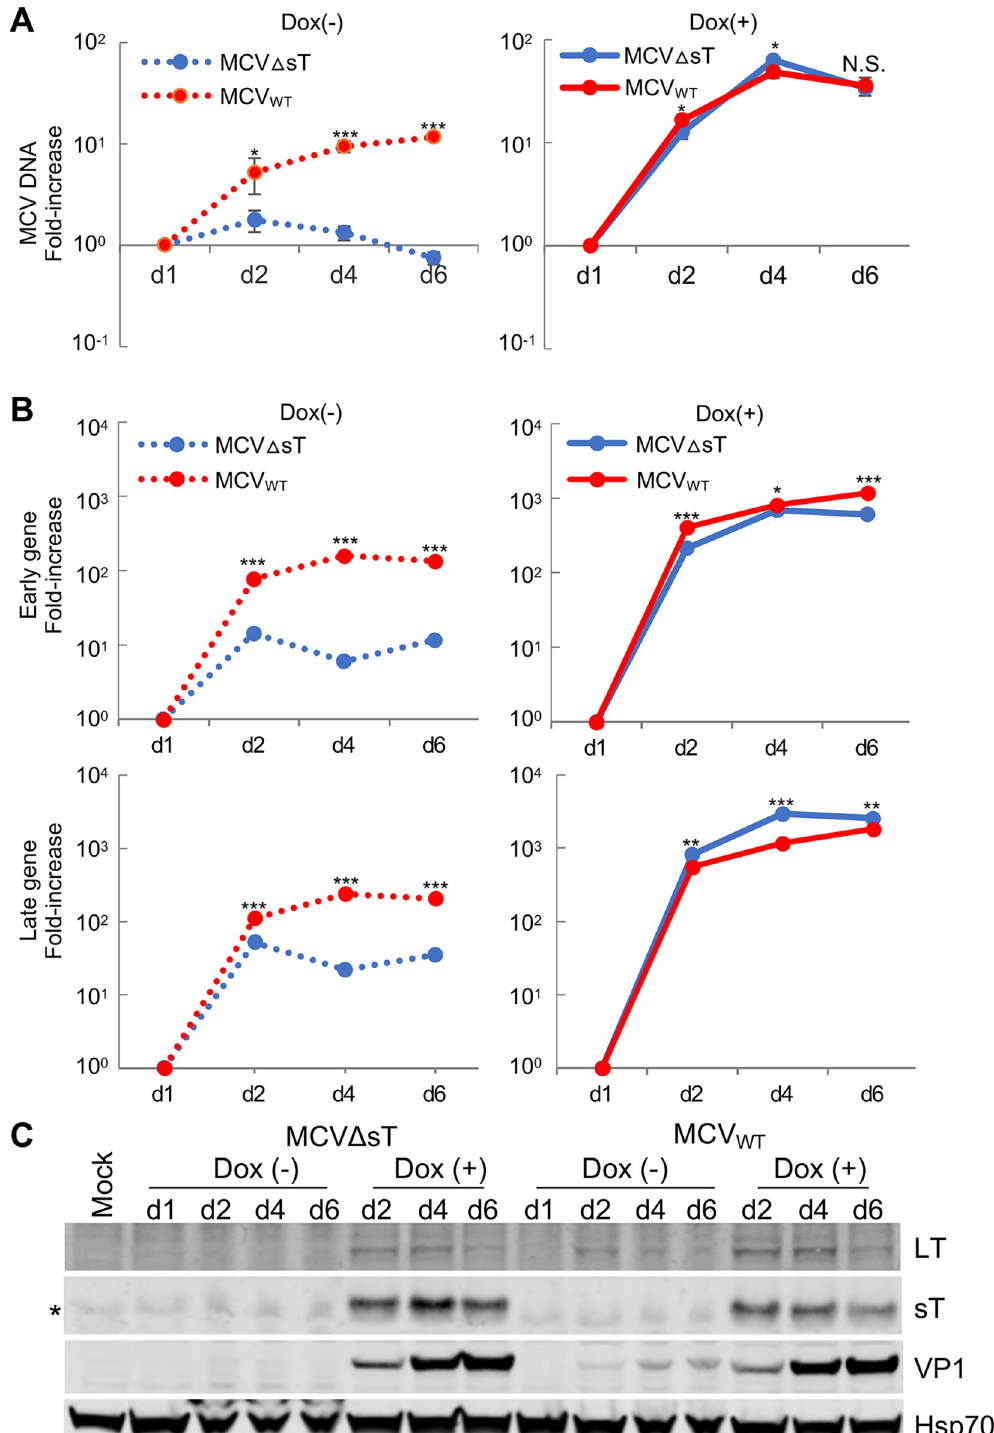
Fig 2. Exogenous sT expression rescues viral DNA replication and mRNA expression in MCV Δ sT. MCV WT and MCV Δ sT viral DNAs were transfected into TRE-sT cells seeded for a 6-day time course experiment. Cells were harvested 24 h p.t. and the remaining cells were treated with or without doxycycline (Dox) at day 1 (0.5 μ g/mL) and paired samples were harvested at day 2, day 4, and day 6 p.t.. Time kinetics in DNA replication, gene expression, and protein expression in both MCV WT (red lines) and MCV Δ sT (blue lines) were analyzed. Unpaired T-test was used for statistical analysis. � , P < 0.05; �� ,